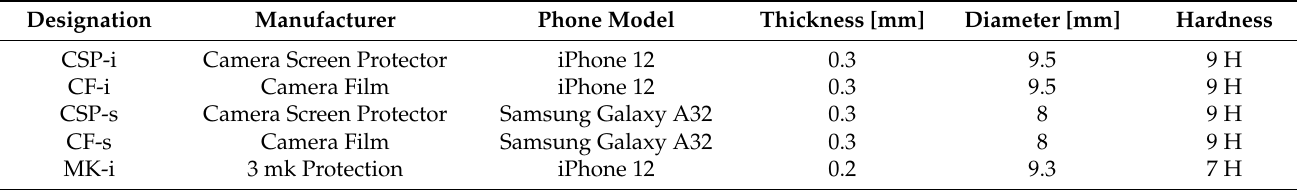
Table 1. List and parameters of tested camera lens glass